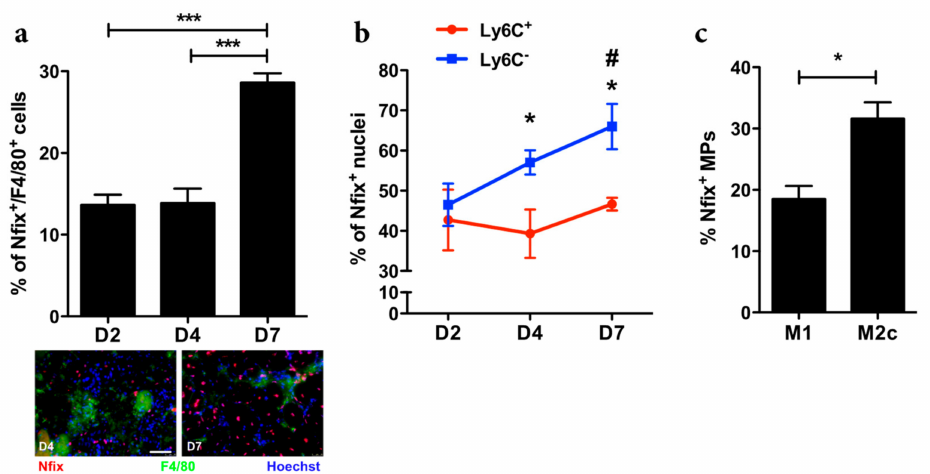
Figure 1. Nfix is mainly expressed by anti-inflammatory MPs. ( a ) Percentage of F4 / 80 + MPs positive for Nfix in Tibialis Anterior muscles (TA) of WT mice injected by CTX at D2, D4 and D7, post-injury. Immunostaining for F4 / 80 (green), Nfix (red) and DAPI (blue) at D4 and D7 after CTX injection; ( b ) Percentage of Ly6C + and Ly6C - sorted MPs positive for Nfix in TA muscles of WT mice injected by CTX at D2, D4 and D7 post-injury; ( c ) Percentage of Nfix + MPs after M1 and M2c polarization (with IFN γ and IL10, respectively). * p < 0.05; *** p < 0.001; for (b) * p < 0.05 Ly6C + vs. Ly6C + at D4 and D7; # p < 0.05 Ly6C − D7 vs. D2. Results are means ± SEM of at least three independent experiments.